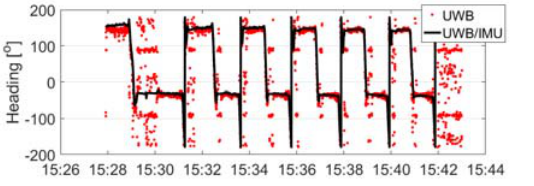
Figure 11. Heading solution from UWB/IMU integration for under canopied area